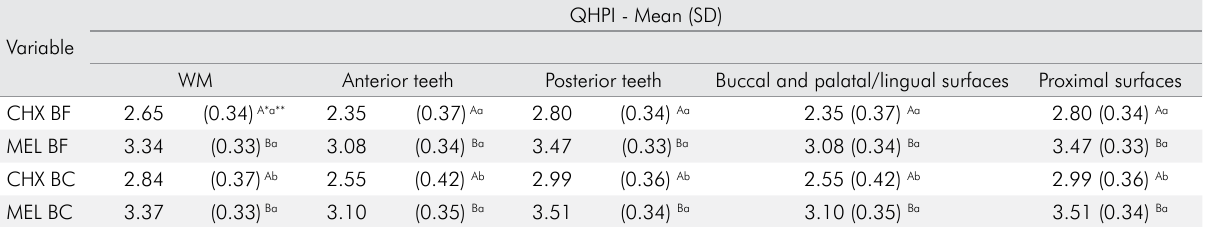
Table 1. Mean values of QHPI (SD) in final examination, using experimental mouthwashes in plaque-free and plaque-covered surfaces (n = 60).